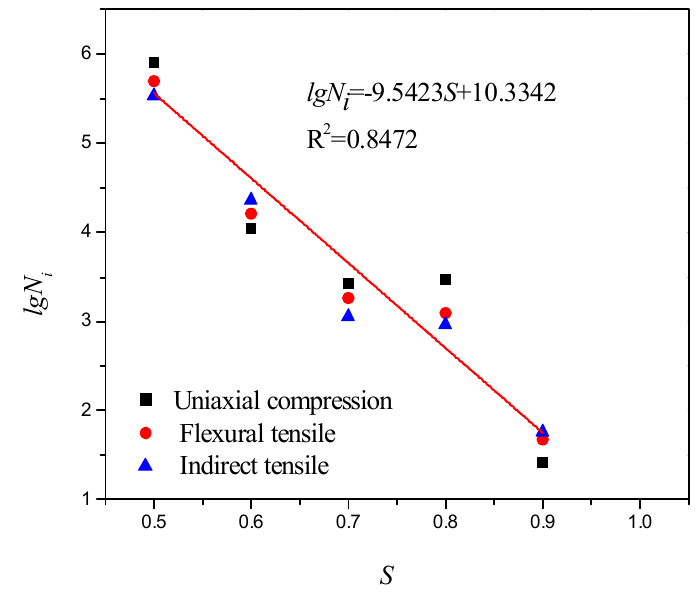
Figure 9. Standardization equations for the fatigue properties with a cement content of 3% at a curing time of 28 days and a guaranteed rate of 95% under different stress states.